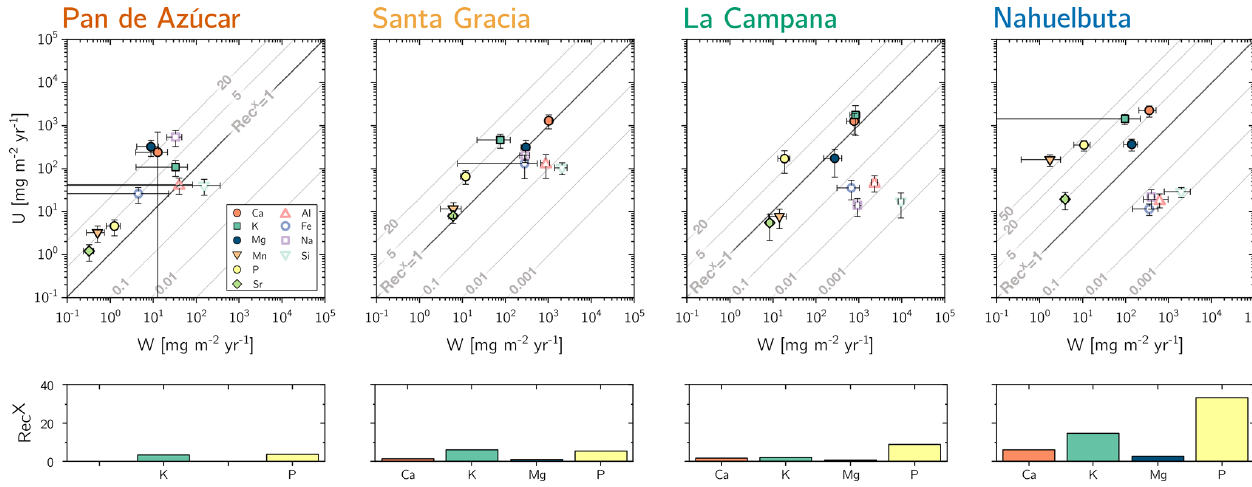
Figure 4. Chemical weathering flux ( W X ) and plant nutrient uptake fluxes ( U X ) for Pan de Azúcar, Santa Gracia, La Campana, and regolith total Nahuelbuta (from left to right) for mineral nutrients. Grey contour lines emphasize the nutrient recycling factor (Rec X ), which is the ratio of U X to W X . Uncertainty bars show 1SD. Differences in nutrient recycling factors for Ca, K, Mg, and P among the four study sites total regolith are highlighted in the lower panels. Note that here we use the Rec X calculated for W X from silicate weathering only. In Table 5 and regolith Fig. A4 we also show Rec X including atmospheric inputs. Because Pan de Azúcar Ca and Mg inputs are exclusively atmospheric, their Rec X is overestimated and thus not plotted on the lower-left panel.